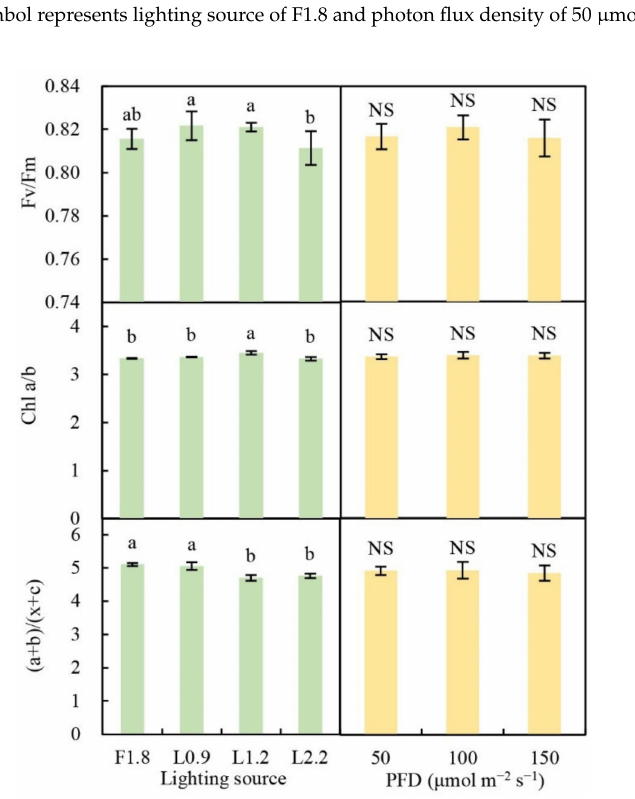
Figure 4. Effects of light quality during the whole seedling period and photon flux density (PFD) in the healing stage on Fv/Fm, ratio of chlorophyll a to chlorophyll b (chl a/b) and ratio of total chlorophylls to total carotenoids ((a + b)/(x + c)) of grafted tomato transplants. There were no interactive effects of light quality and PFD on Fv/Fm ( P = 0.056), chl a/b ( P = 0.440) and (a + b)/(x + c) ( P = 0.256). Duncan’s test was used to make post-hoc multiple comparisons at α = 0.05 level ( n = 6). Vertical bars represent standard deviations. Different letters, a and b, indicate significant differences and NS indicates nonsignificant